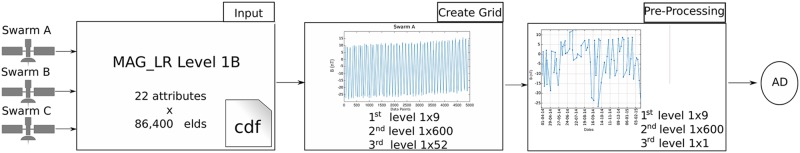
Data structure throughout the different stages of the process.